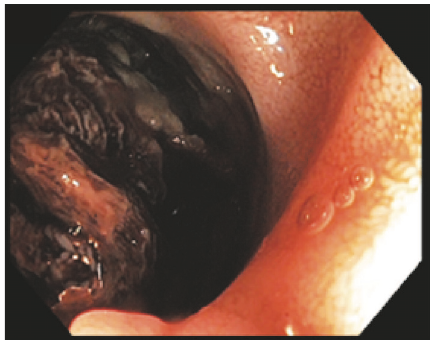
Figure 6: Endoscopy image; ulcer located in distal duodenum.